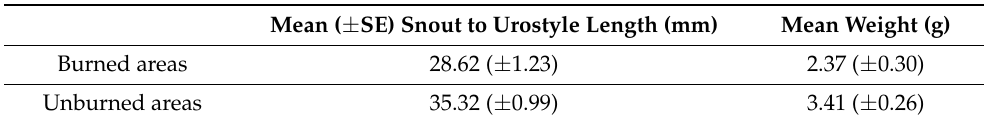
Table 1. Mean snout to urostyle length and mean weight of green tree frogs captured in burned versus unburned